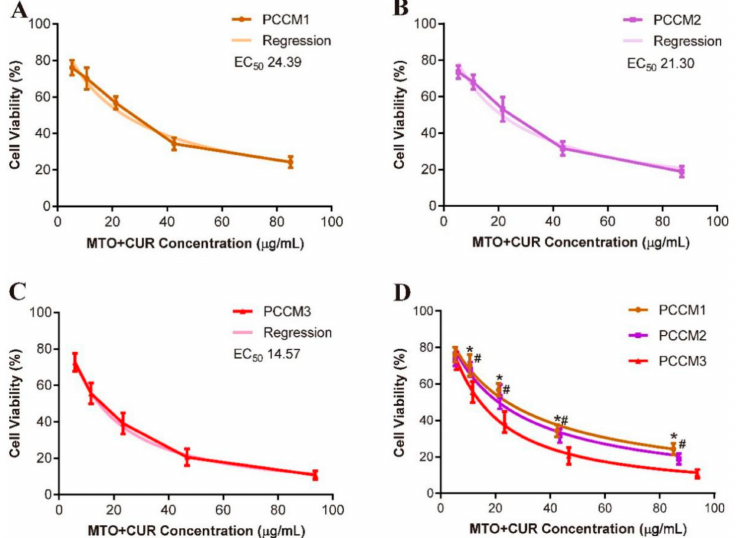
Figure 7. Dose–effect curves and the regressions of: PCCM1 ( A ); PCCM2 ( B ); PCCM3 ( C ); and all PCCM NPs for comparison ( D ). Data represent means ± SD ( n = 6). Statistics: * indicates significant differences between PCCM1 and PCCM3 ( p < 0.05); # indicates significant differences between PCCM2 and PCCM3 ( p < 0.05). There was no significant difference between PCCM1 and PCCM2.